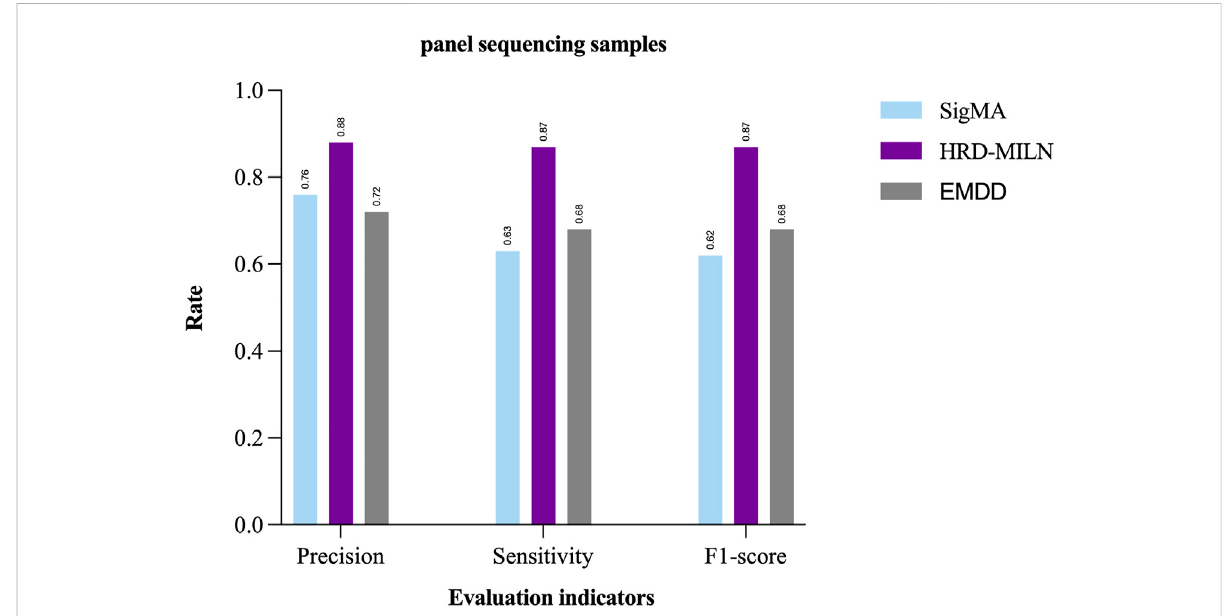
FIGURE 3 TheperformancesofSigMA, EMDD,andHRD-MILN inpanel sequencingsamples. HRD-MILN hadthehighestscores (precision0.88,sensitivity 0.87, F1-score 0.87) than SigMA and EMDD on each Evaluation indicator.